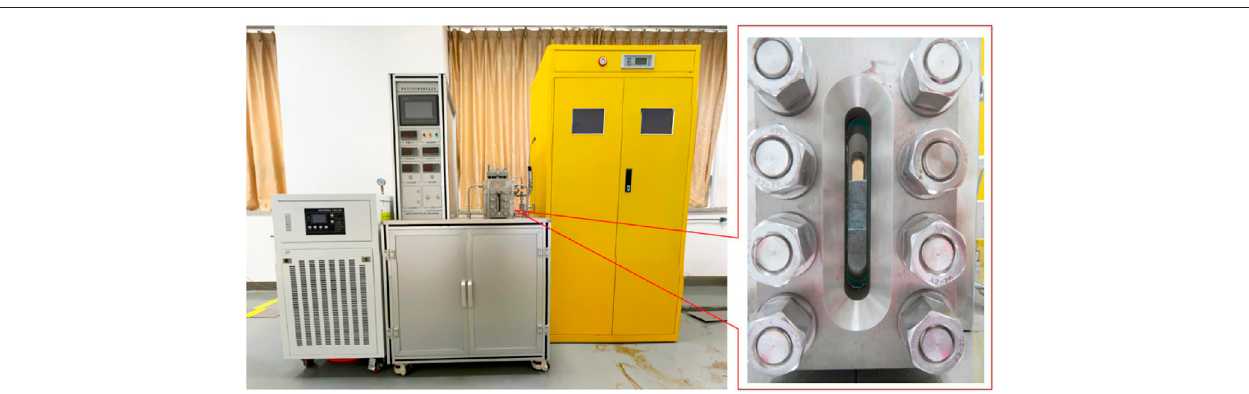
FIGURE 3 | Visualization device for interaction between supercritical CO 2 and